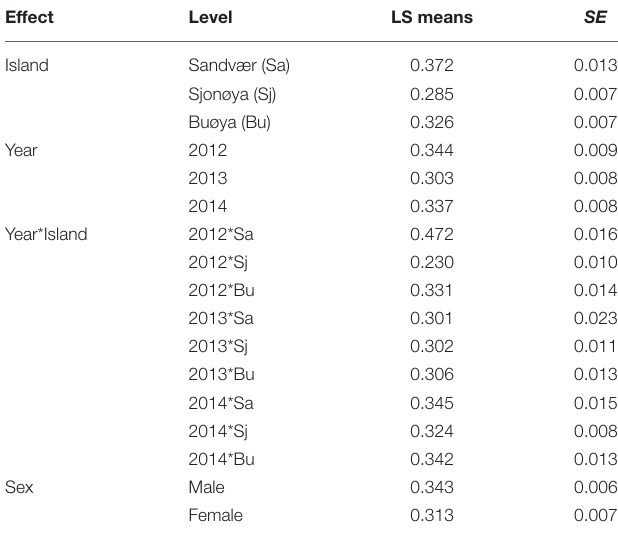
TABLE 5 | Least squared means (LS means) corrected for the other effects in the model for lambs average daily gain (kg d − 1 ) on island pasture, with standard error (SE), for class variables island, year, year * island, and sex in the mixed